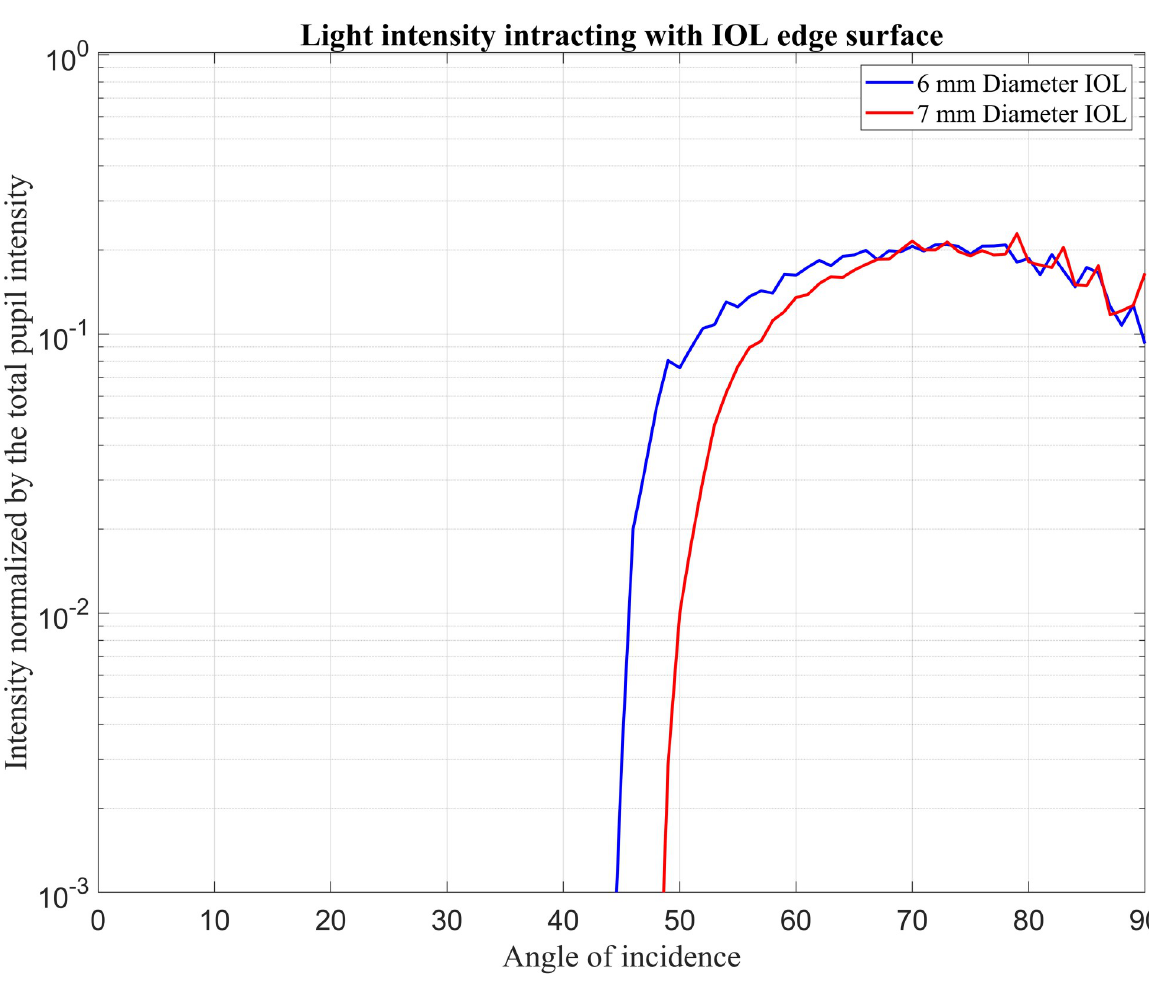
Fig 4. Normalised input intensity detected by the Detector-E over the incident ray